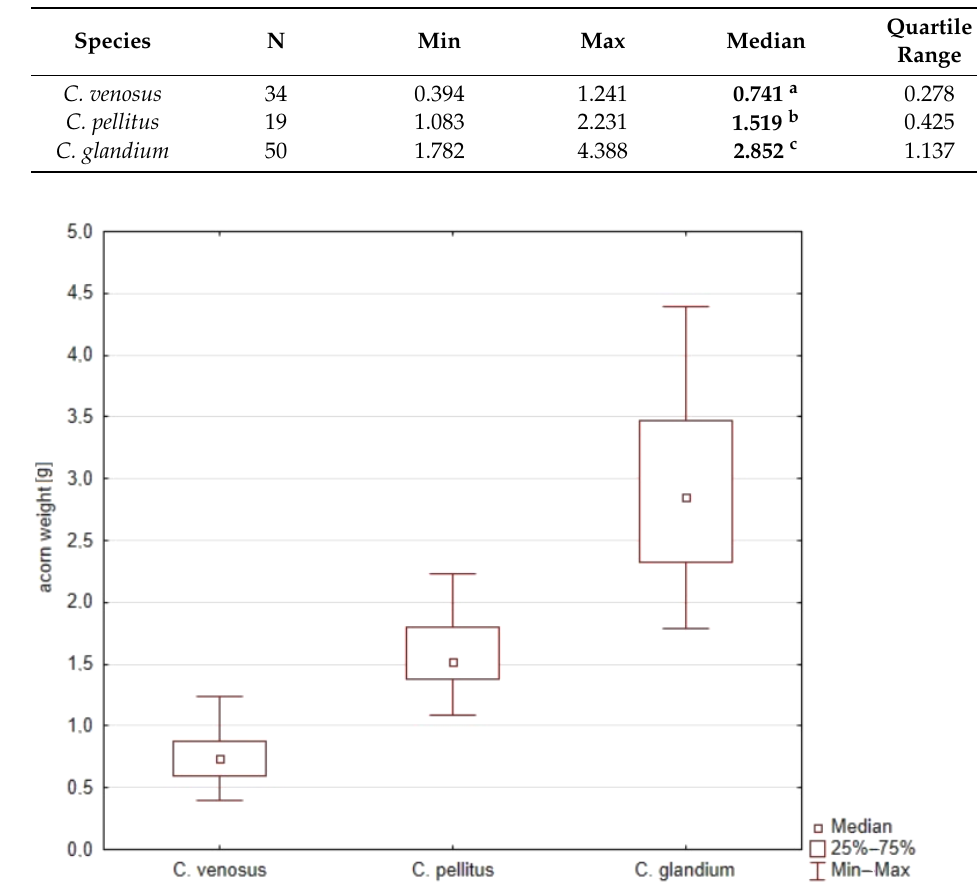
Figure 2. Significant differences between masses of acorns chosen for oviposition by females repre- senting three Curculio species (Kruskal–Wallis’ test, p < 0.05).